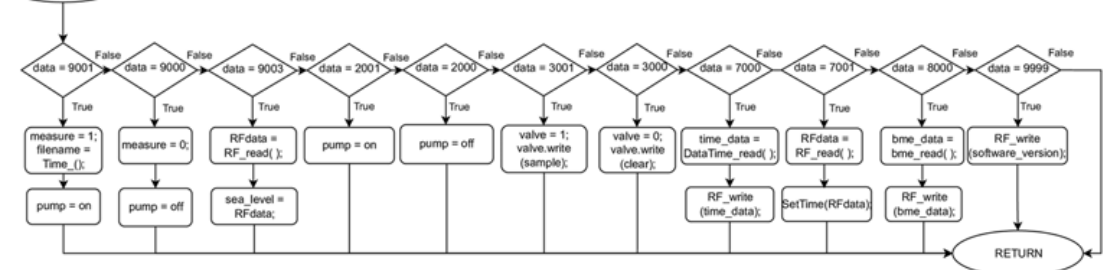
Figure 8. The process of interpreting the transmitted information and taking appropriate action.